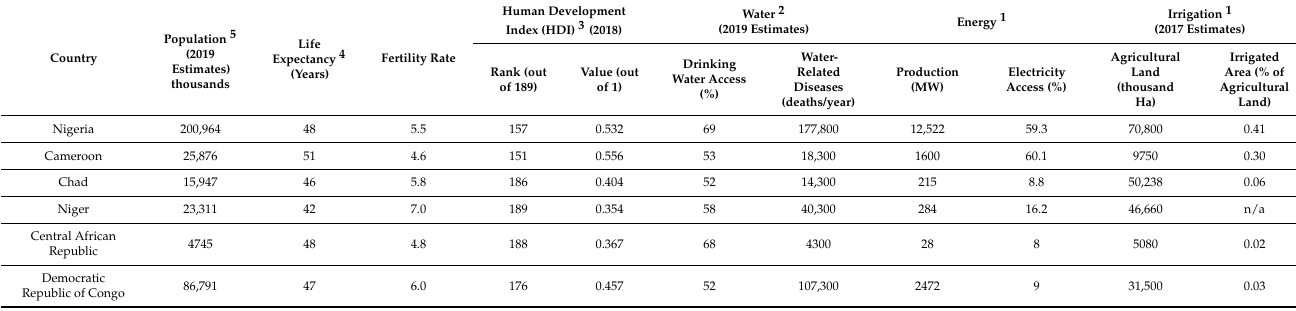
Table 1. Nigeria’s comparative position in water-related sectors with countries in West and Central Africa.